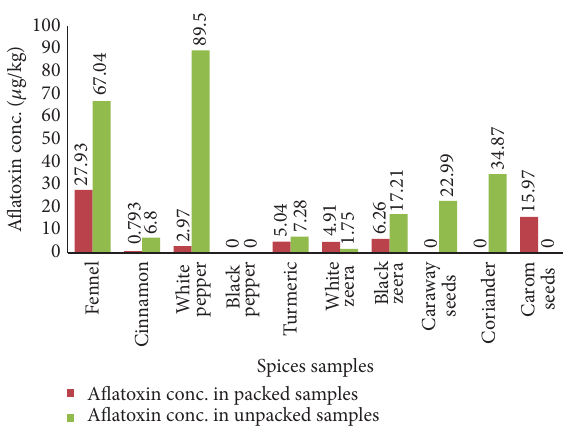
Figure 3: Comparison of aflatoxin conc. in packed and unpacked spice